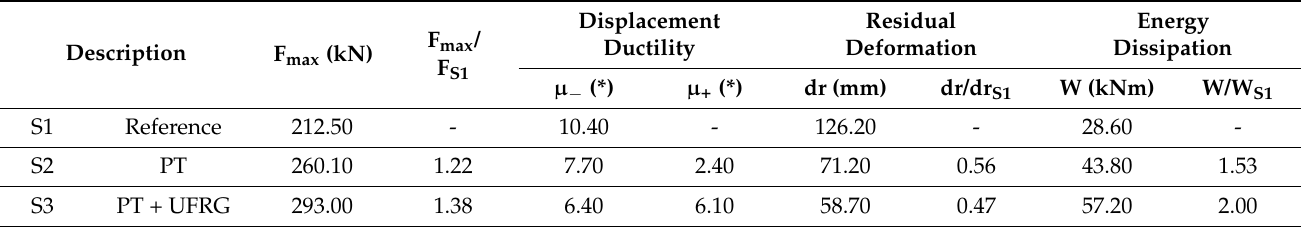
Table 2. Performance evaluation